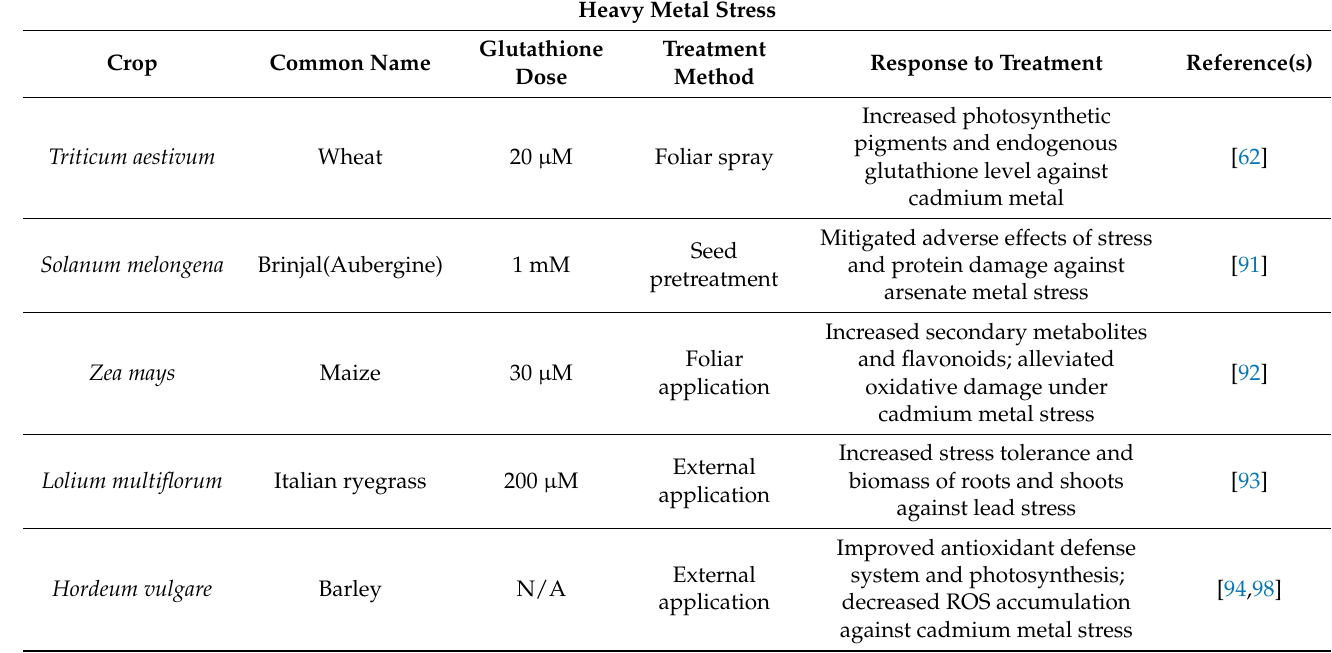
Table 10. Physiological responses of various crops to glutathione treatment against heavy metal